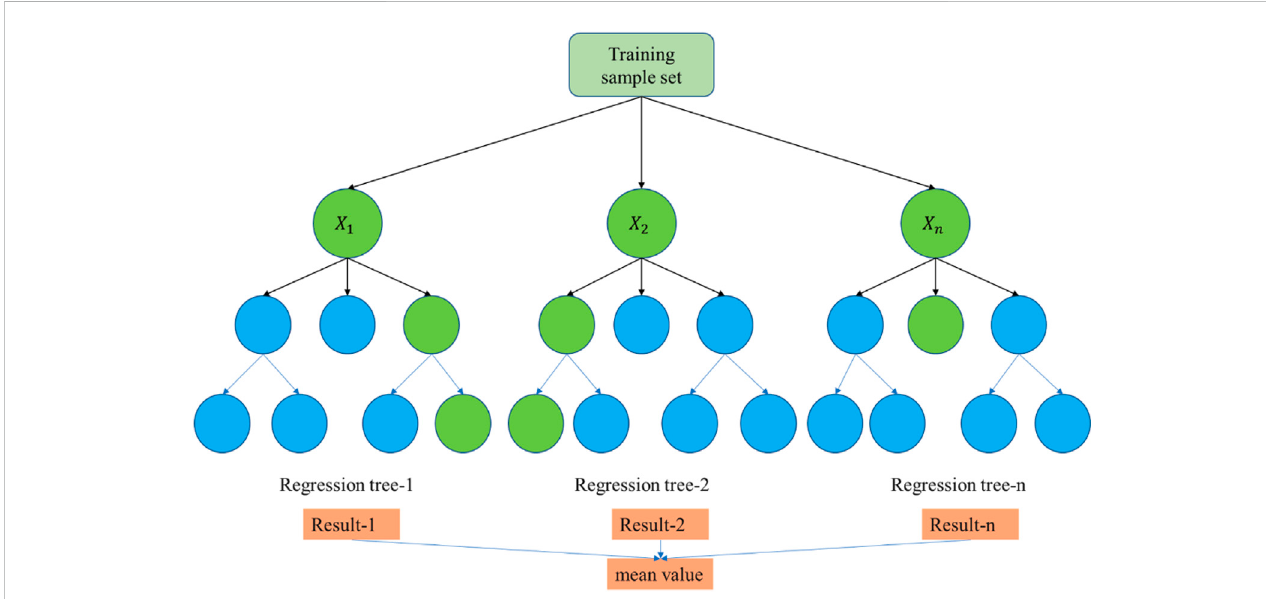
FIGURE 3 Schematic diagram of the RF algorithm.